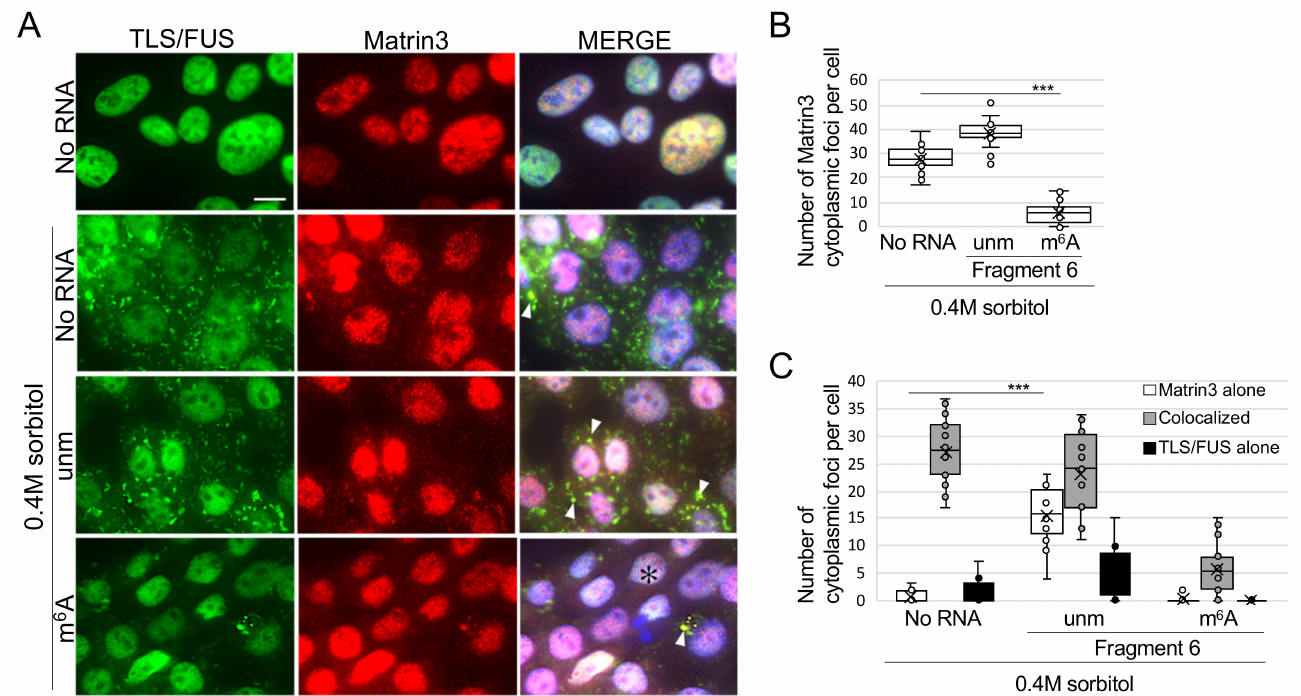
Figure 5. Matrin3 colocalized with cytoplasmic TLS/FUS foci after sorbitol treatment, but m 6 A-modified RNA fragment impaired this colocalization. ( A ) RNA Fragment 6 with or without m 6 A modification was transfected to HAP1 cells prior to 0.4M sorbitol treatment. Representative images of ICC are shown. MERGE images indicate the layered images of TLS/FUS, Matrin3, and DAPI (for nuclei staining). White arrowheads, colocalized TLS/FUS and Matrin3 foci; ∗ , cells with cytoplasmic Matrin3 foci independent of TLS/FUS. Scale bar = 10 µ m. ( B , C ) Cytoplasmic foci in ( A ) were quantified. n = 20. unm, unmodified fragment; m 6 A, m 6 A modified fragment. *** p <